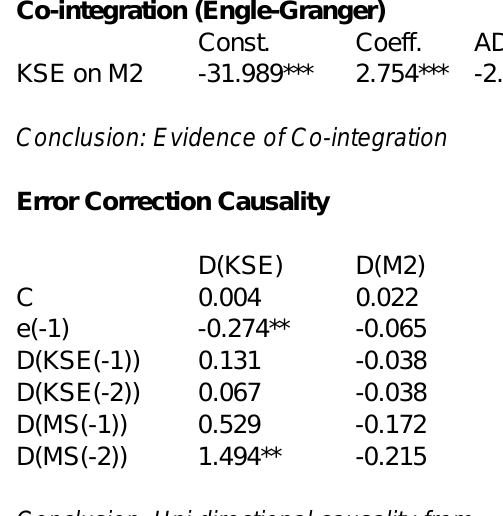
Table 3: Stock Index and Money